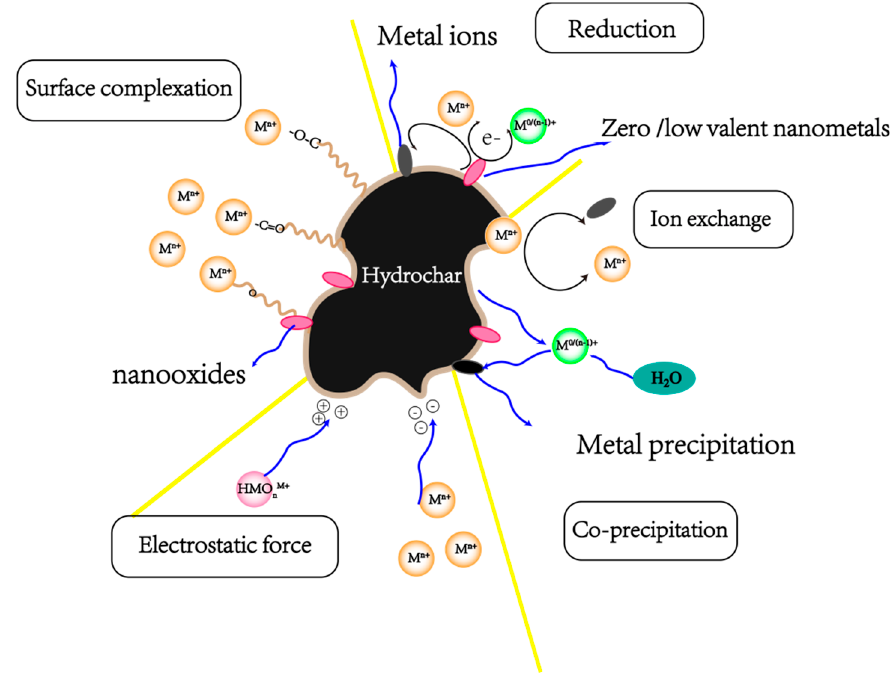
Figure 5. Mechanism of heavy metal ion adsorption by